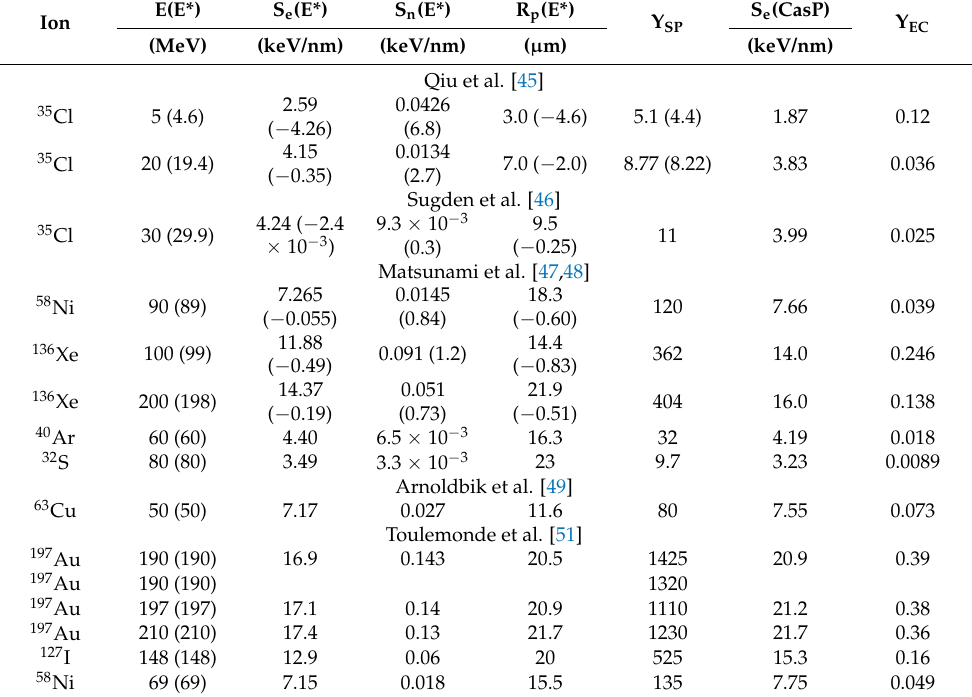
Table 2. Sputtering data of SiO 2 (normal incidence). Ion, incident energy (E in MeV), energy (E* in MeV) corrected for the energy loss in carbon foils (see footnote), electronic stopping power (S e ), nuclear stopping power (S n ), projected range (R p ) and sputtering yield (Y SP ). S e , S n and R p are calculated using SRIM2013. (S e (E*)/S e (E) − 1), (S n (E*)/S n (E) − 1) and (R p (E*)/R p (E) − 1) in % are given in the parentheses after S e (E*), S n (E*) and R p (E*), respectively. Y SP in the parenthesis is for SiO 2 films. S e (E) by CasP is also listed. Y EC is the calculated sputtering yield due to elastic collisions. E(E*) S e (E*) S n (E*) R p Ion